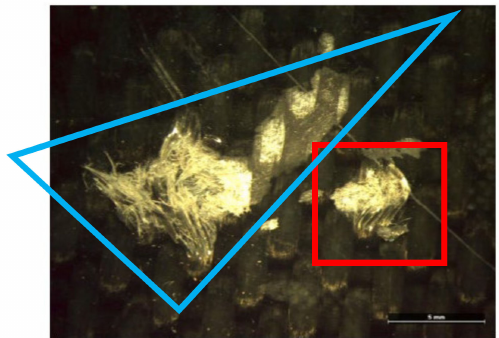
Figure 9. Optical image of the top face of panel 11 highlighting the damages cause by the first impact (red square) and the second impact (blue triangle).